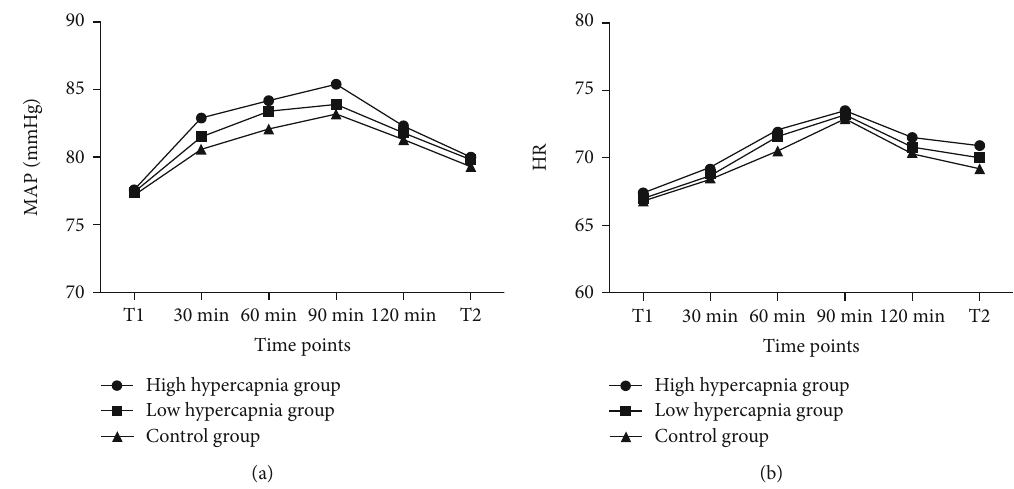
Figure 3: Analysis of hemodynamic measures. The di ff erence in the levels of MAP (a) and HR (b) was not signi fi cant at each time point in the three groups. T1: before operation; T2: 30 min after